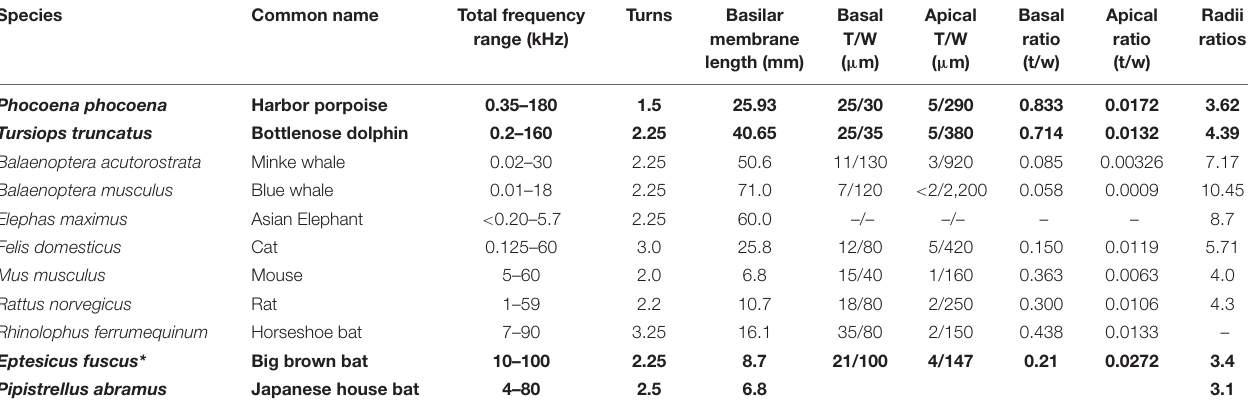
TABLE 3 | Cochlear morphometry of high and low frequency adapted cetacean and terrestrial mammals.